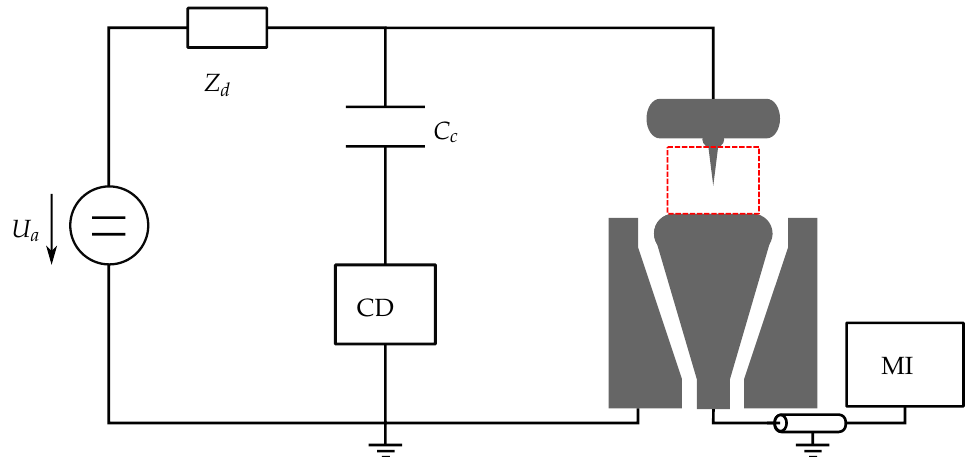
Figure 6. Scheme of the measurement setup based on [22] and simulated area (red